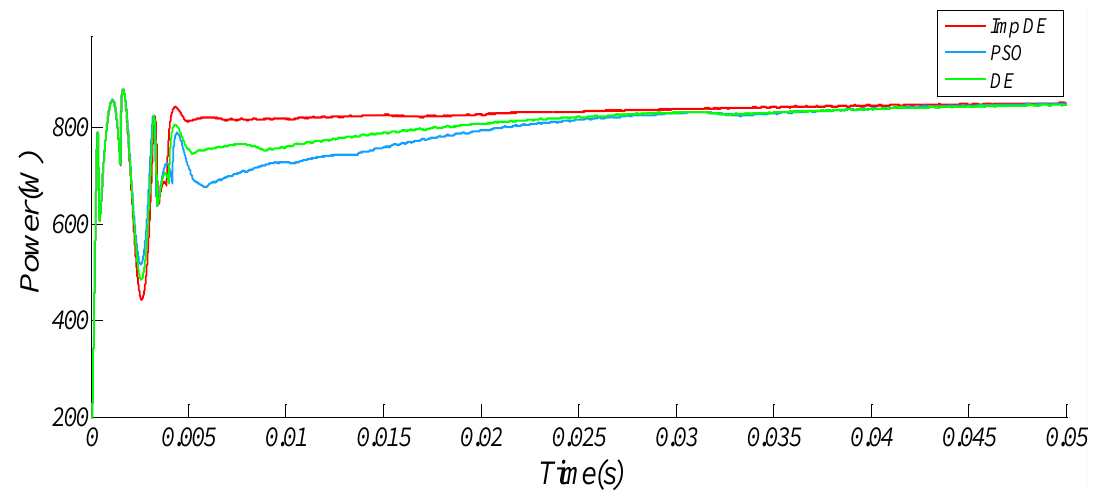
Table 2. Comparisons of convergence speed, accuracy and iteration times of the three methods.